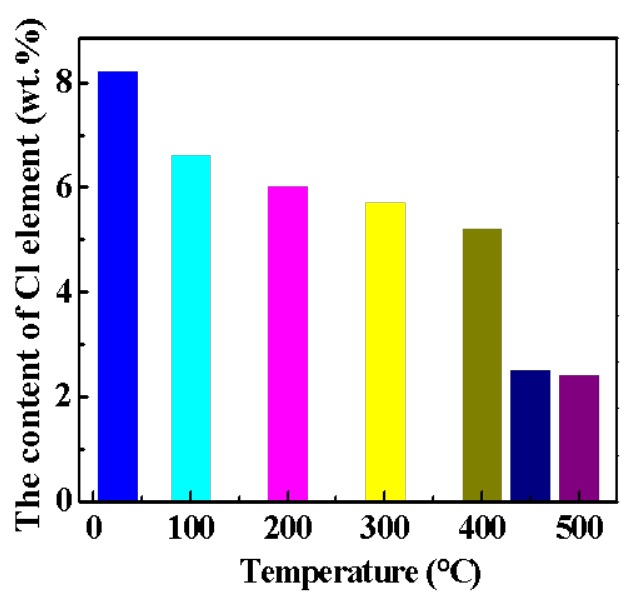
Figure 3. Content of Cl element in MOC after being heated at various temperatures .